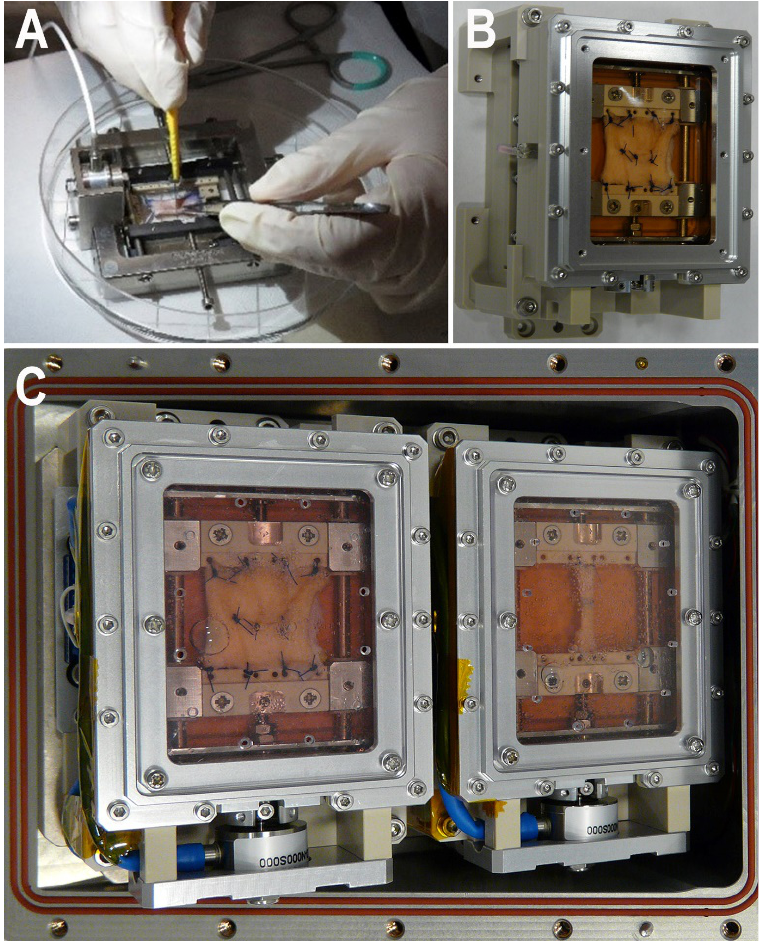
Figure 1. Representative photographs of the Experimental Unit (EU). ( A ) Detail of the stainless steel frame during surgical manipulation; ( B ) EU with a mounted skin specimen and a sutured surgical wound; ( C ) Two operating EUs assembled in an Advanced Experiment Container to be inserted into the Biolab facility of the Columbus module at the ISS.